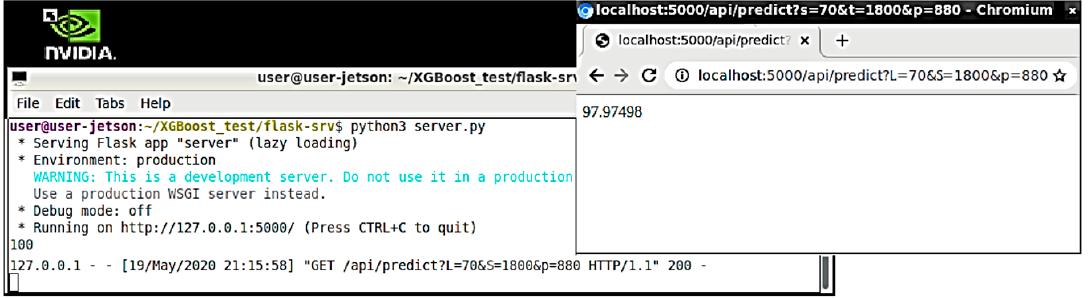
Figure 19. LXDE (light-weight X11) directives, intranet ANN invoking, and Pe prediction publishing using a normal browser.